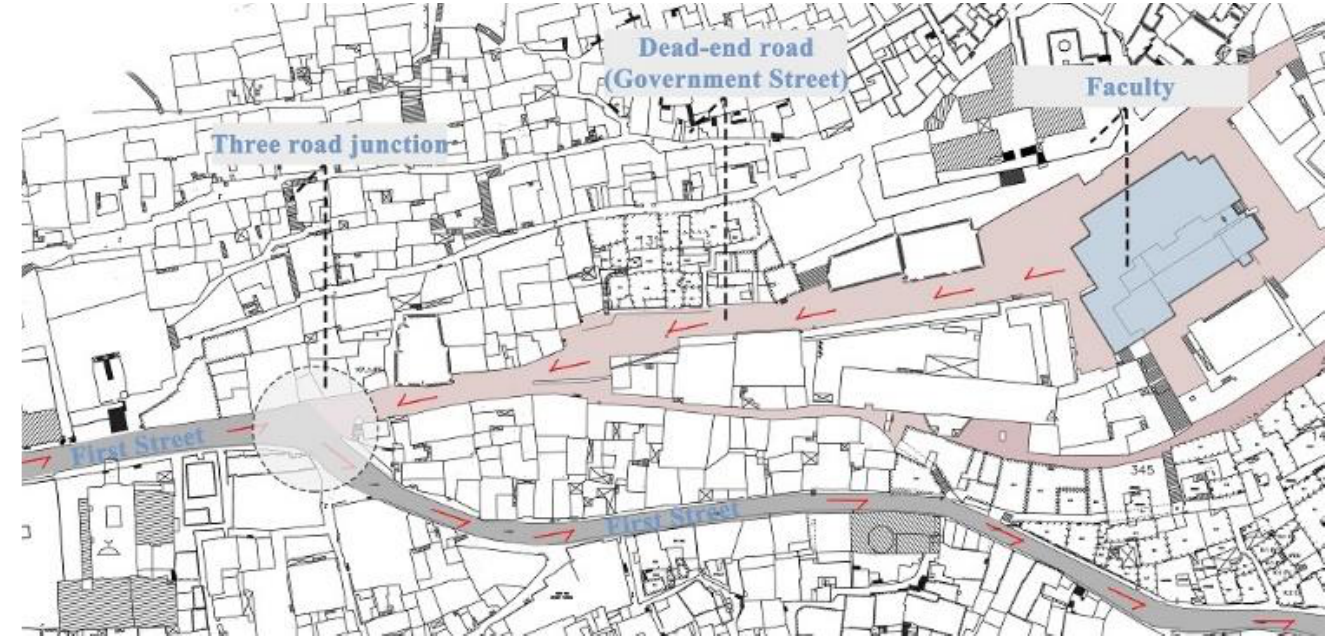
Fig. 12. Access to the faculty [created by the